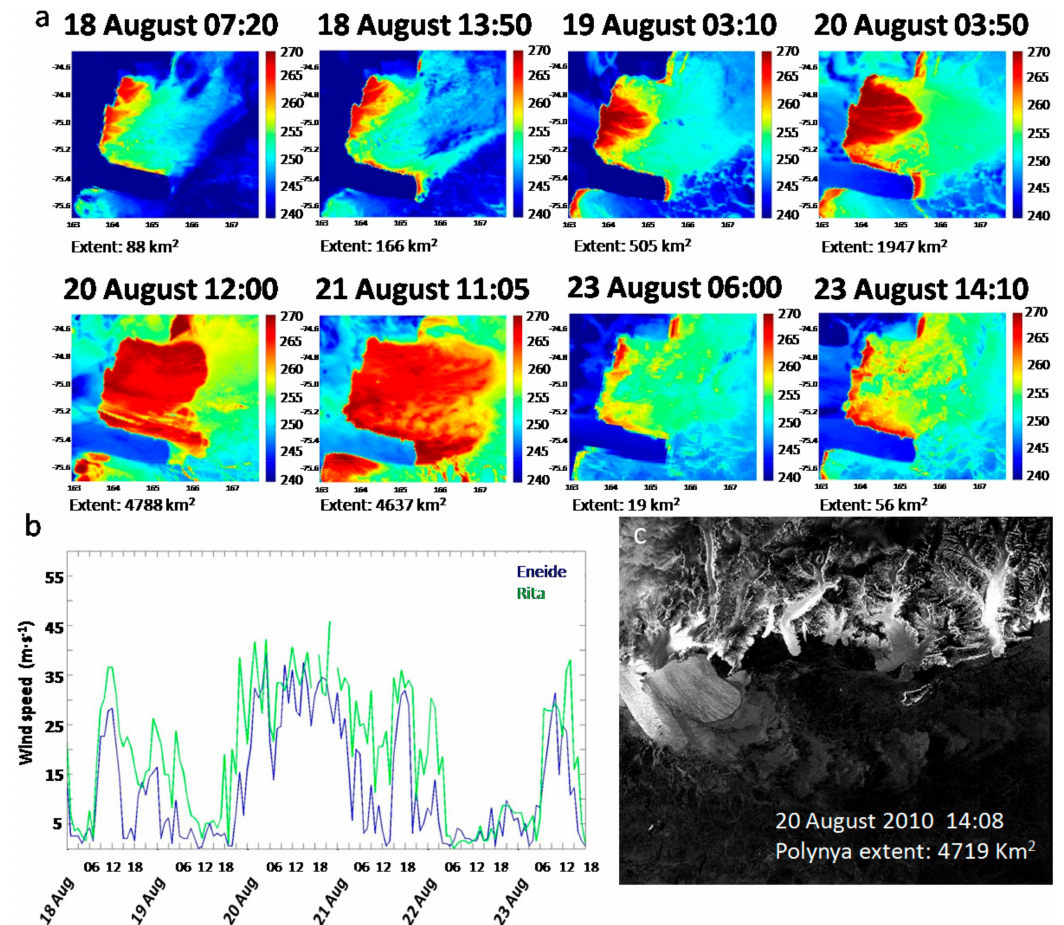
Figure 6. ( a ) Terra Nova Bay polynya extent variability between 18 and 23 August 2010 as seen through a selection of MODIS IST scenes; ( b ) AWS Rita (green) and Eneide (blue) wind records from 18 to 23 August 2010; ( c ) polynya extent retrieved through ENVISAT ASAR Wide Swath image acquired on 20 August 2010 at 14:08 during ascending orbit 44,295—track